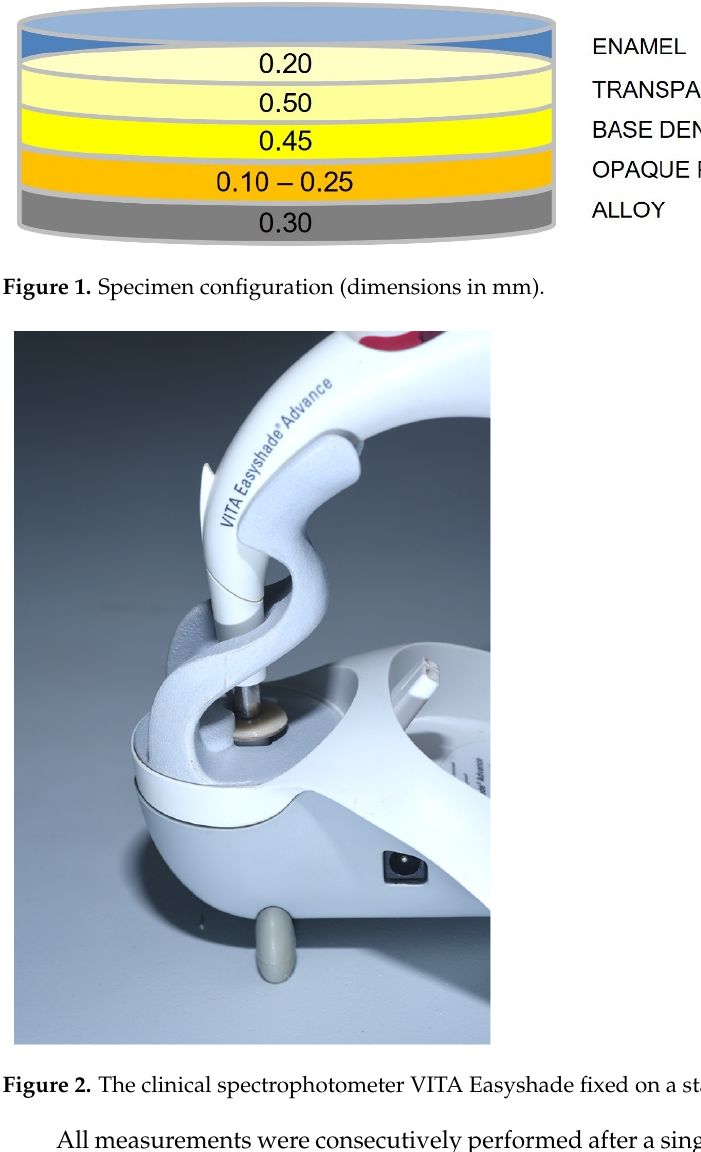
Figure 1. Specimen configuration (dimensions in mm).